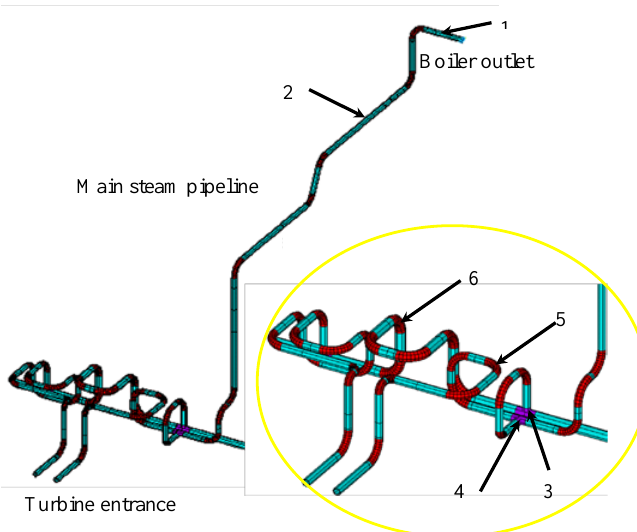
Figure 1. Diagram of the main steam pipeline and monitoring points.